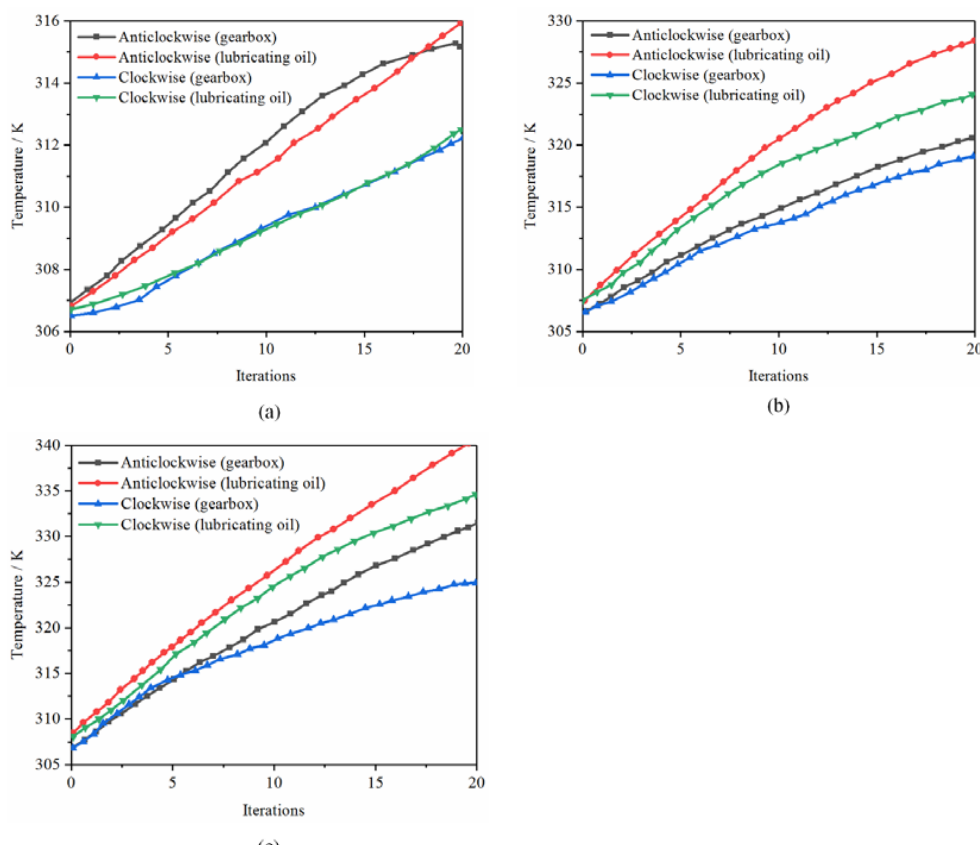
Figure 8. Comparison of gear steering temperature appreciation under different rotation velocities: ( a ) 1000 rpm; ( b ) 2000 rpm; ( c ) 3000 rpm.